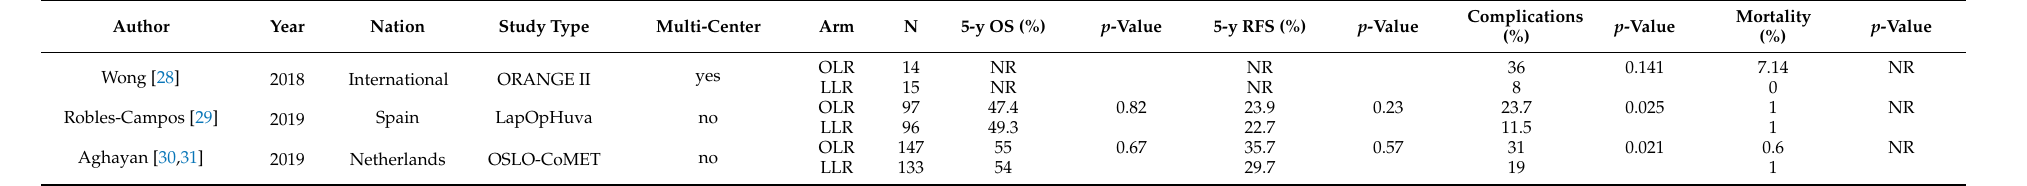
Table 2. Randomized control trials comparing laparoscopic and open liver